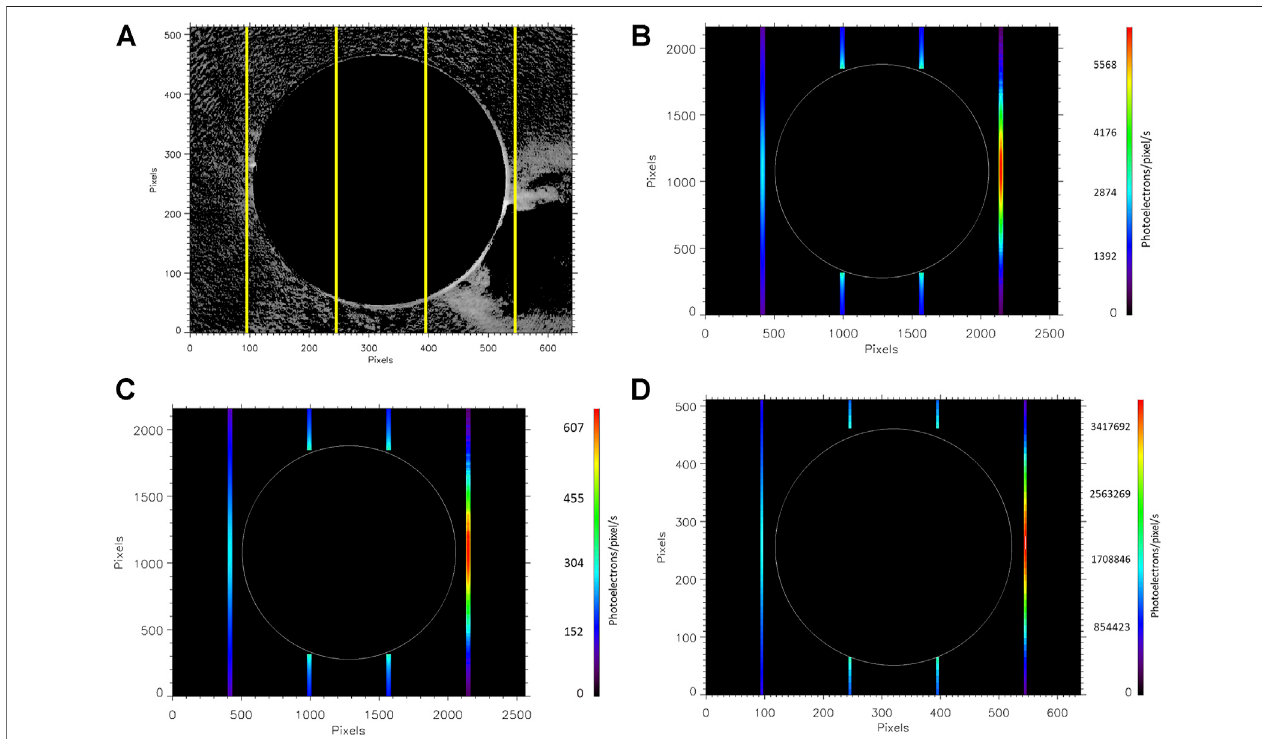
FIGURE4|(A) VELCslitlocationsoverplottedinyellowontheKCorimageof2016-01-01fortheVELCFOVintheIRchannel. (B) , (C) ,and (D) Synthesizedspectra forthefourslitsofVELCfor5,303,7,892,and10,747